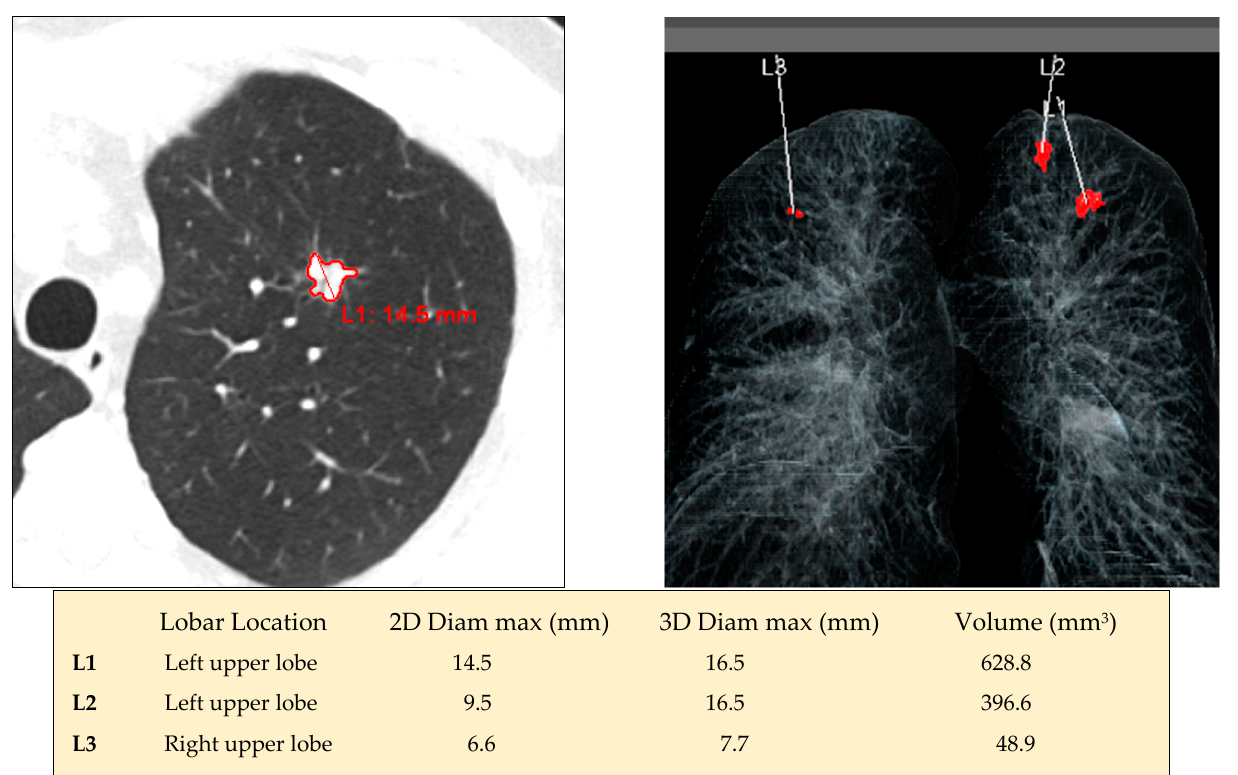
Figure 2. Automatic detection of 3 solid nodules in a 56 current smoker using the AI-RAD Companion (Siemens Healthinners) solution. ( Left top ): axial CT image that shows the results of the automatic segmentation and contouring of the largest left upper lobe nodule. ( Right top ): coronal view that summarizes all lung nodules detected by the CAD system with their location (red). ( Bottom ): table that reports the lobe location, 2D and 3D diameters, and volume of the 3 detected nodules.